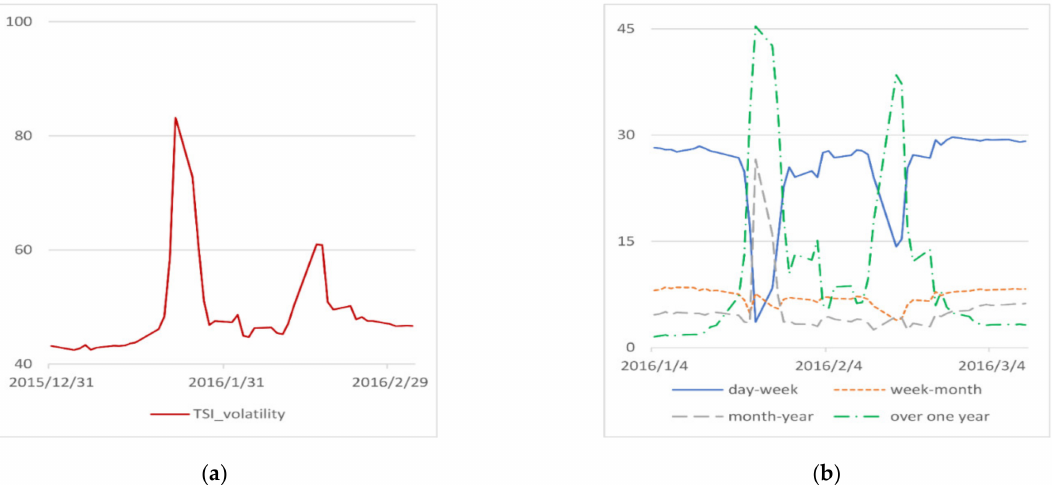
Figure 7. Total spillover of the price volatility system during the 2015–2016 oil price decline. ( a ) total volatility spillover. ( b ) frequency decomposition of volatility